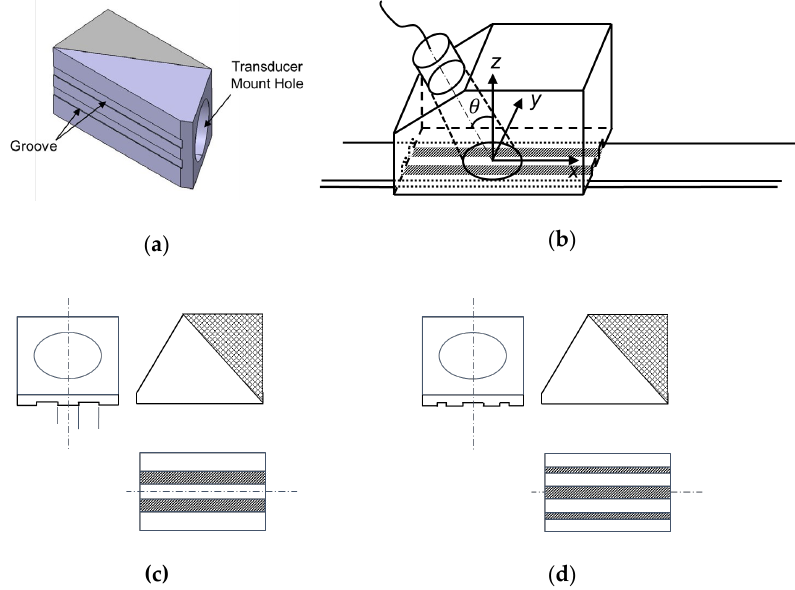
Figure 6. (a) Groove-based wedge and (b) its working principle; the shadowed are insulated regions. Groove-based wedges for A(0,4) mode with (c) negative-insulation pattern and (d) positive-insulation pattern.